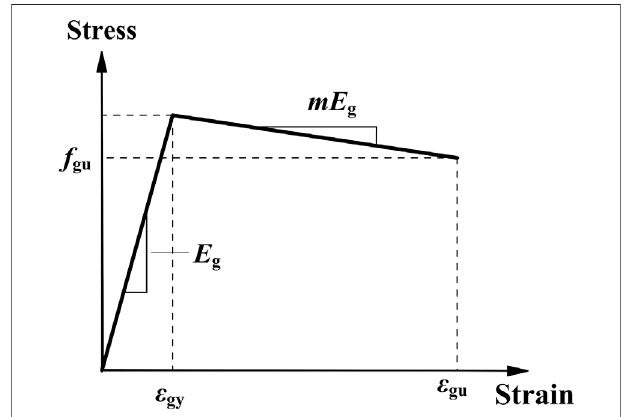
FIGURE 7 | Stress – strain relationship of glulam in the FEM model.